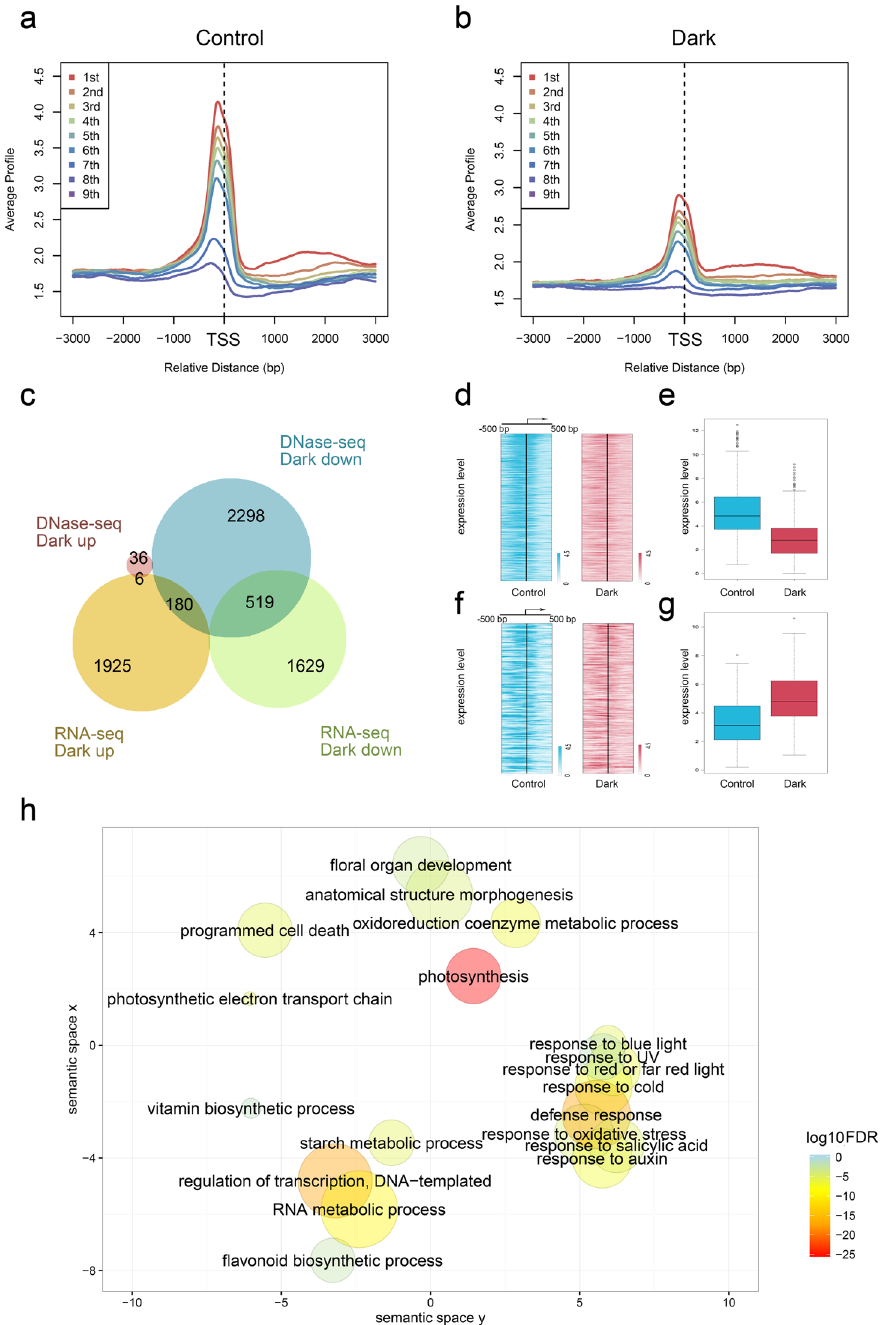
Figure 2. Integrated analysis of DHS-changed and differentially expressed genes. ( a , b ) The distribution of DHSs along 3 kb upstream and downstream of TSSs of Arabidopsis genes with different expression level under control ( a ) and extended darkness ( b ), respectively. All expressed genes were divided into 9 bins, which were expressed genes (FPKM > 0) from high expression (1st) to low expression (9th) based on the expression levels. ( c ) Venn diagrams between DHS-changed genes and differentially expressed genes under extended darkness. ( d ) DHS intensities around TSSs of the group of 519 genes from ( c ) under extended darkness and control conditions, respectively. The genes were sorted according to the expression level determined by FPKM under control condition. For each gene, the DHS intensities are displayed along − 500 bp to 500 bp regions around the TSS. ( e ) The gene expression values are shown for the group of 519 genes from ( c ). ( f ) DHS intensities around TSSs of the group of 180 genes from ( c ) under extended darkness and control conditions, respectively. The genes were sorted according to the expression level determined by FPKM under control condition. For each gene, the DHS intensities are displayed along − 500 bp to 500 bp regions around the TSS. ( g ) The gene expression values are shown for the group of 180 genes from ( c ). ( h ) GO enrichment analysis of 519 genes in ( c ) by agriGO and REVIGO. The scatter plot shows the cluster representatives in a two-dimensional space derived by applying multidimensional scaling to a matrix of the significant GO terms with semantic similarities. Bubble color and size indicates the log 10 (FDR p-value) (legend in bottom right-hand